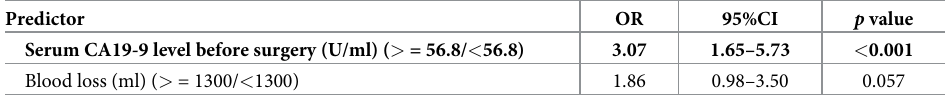
factor, the overall incidence rate of early recurrence and site of initial recurrence were com- pared according to the presence or absence of the factor. The serum CA19-9 level before sur- gery > = 56.8 U/mL (n = 69) was associated with significantly higher overall incidence rate of early recurrence after surgery and that of hepatic recurrence (serum CA19-9 level before sur- gery > = 56.8 U/mL vs. < 56.8 U/mL: 58.0 and 29.0% vs. 28.4 and 14.2%; p < 0.001 and p = 0.013, respectively) (Fig 3A). The overall incidence rate of local recurrence after surgery was higher in the patients with serum CA19-9 level before surgery > = 56.8 U/mL than in those with serum CA19-9 level before surgery < 56.8 U/m, but the difference was not statisti- cally significant. The overall incidence rates of peritoneal and pulmonary recurrence were comparable between the two groups. The 1-and 2-year cumulative incidence rates of recur- rence and those of hepatic recurrence were significantly higher in the patients with serum CA19-9 level before surgery > = 56.8 U/mL than in those with serum CA19-9 level before sur- gery < 56.8 U/mL (Fig 3B and 3C). Serum CA19-9 level before surgery > = 56.8 U/mL was associated with significantly lower rates of recurrence-free and overall survival (Fig 4). Table 4. Multivariate analysis of perioperative factors contributing to early recurrence after surgery in the local- ized pancreatic cancer patients with curative-intent resection after preoperative